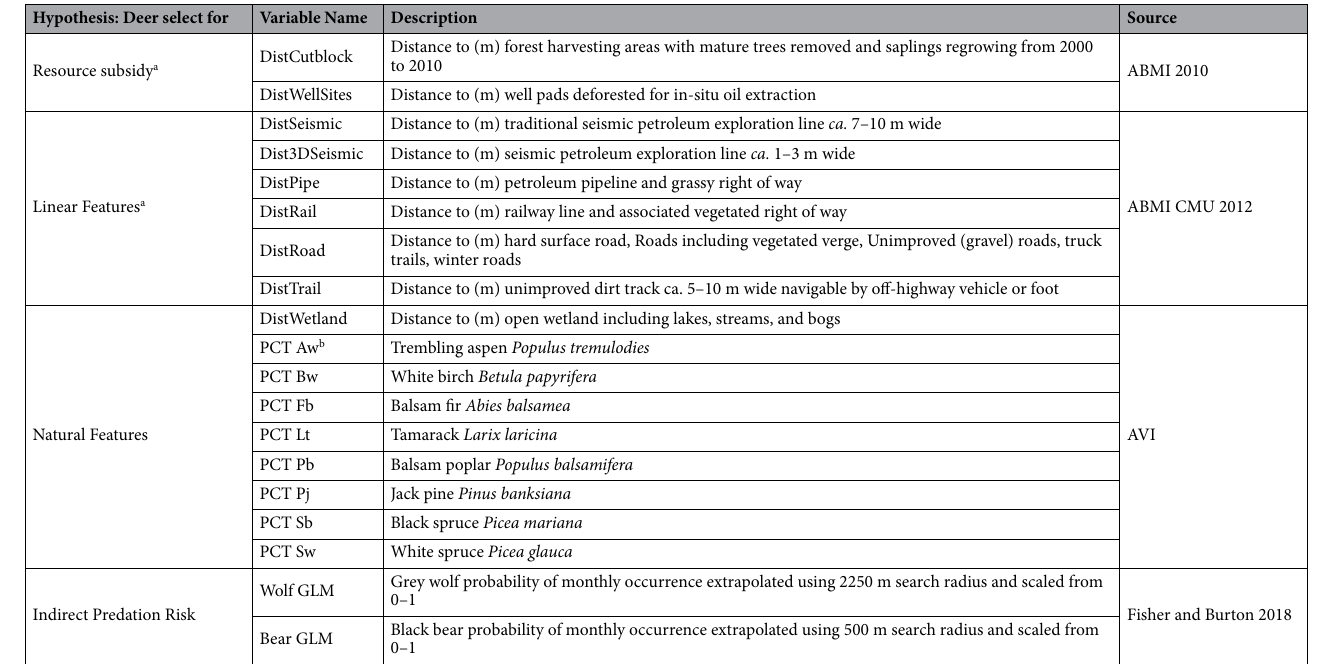
Table 1. Core hypotheses and corresponding landscape variables used to quantify natural landscape features from the Alberta Vegetation Inventory (AVI), and anthropogenic landscape features from two sources: industrial linear features from the Alberta Biodiversity Monitoring Institute (ABMI) Caribou Monitoring Unit (CMU) updated to 2012, and industrial block features from the ABMI human footprint project updated from 2010. All distance-to metrics are measured in metres (m). a These are composite variables, we measured the distance to the closest of any of these features. b PCT refers to the percent of the forest canopy overstorey dominated by this leading tree species. AVI data were created and provided by Alberta Environment and Sustainable Resource Development 2010. Provincial Human Footprint layers and 2012 linear features were provided by ABMI and University of Alberta, Integrated Landscape Management